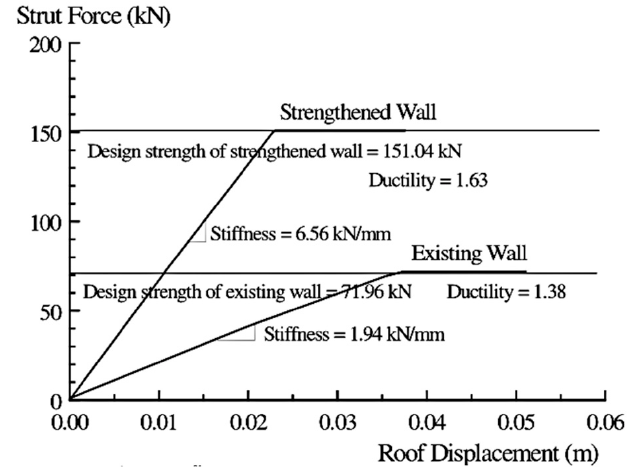
Figure 10. Comparison of the original column and reinforced column.